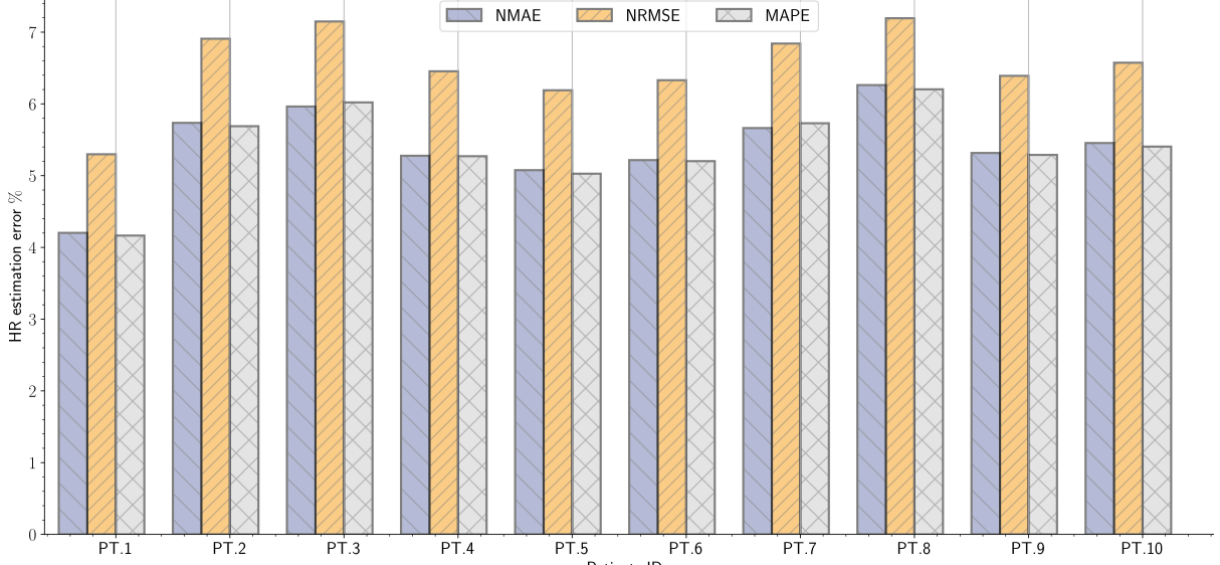
Figure 14. Bar plots of the normalized mean absolute error, normalized root mean square error, and mean absolute percentage error between reference device (electrocardiogram) and the microbend fiber optic sensor for heart rate estimation. HR: heart rate; MAPE: mean absolute percentage error; NMAE: normalized mean absolute error; NRMSE: normalized root mean square